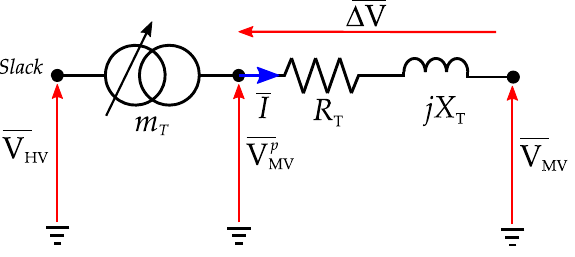
Figure 8. On-Load Tap Changing ( OLTC) Electric transformer in a DN.